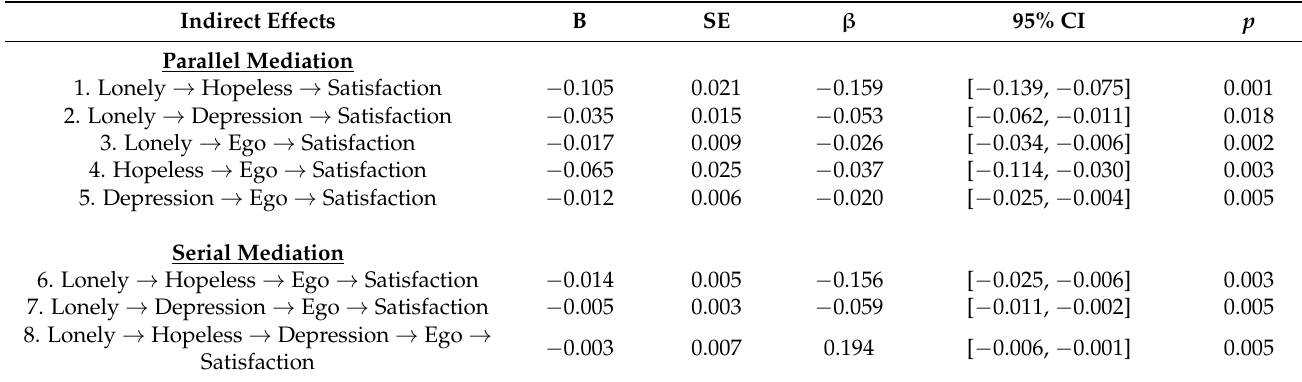
Table 3. Indirect effects of the predictor variables and